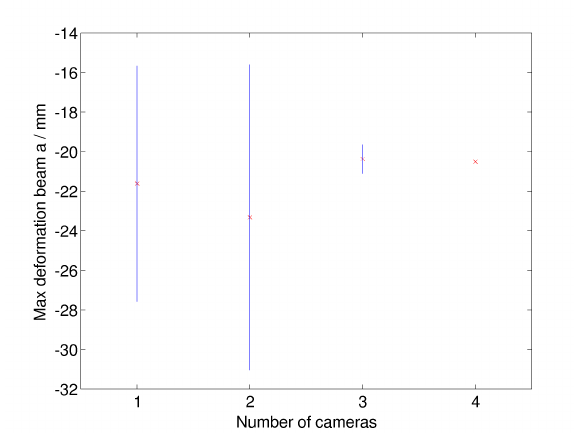
Figure 7: Deformation in the middle of beam a or beam b ± sample standard deviation as a function of the number of cameras.